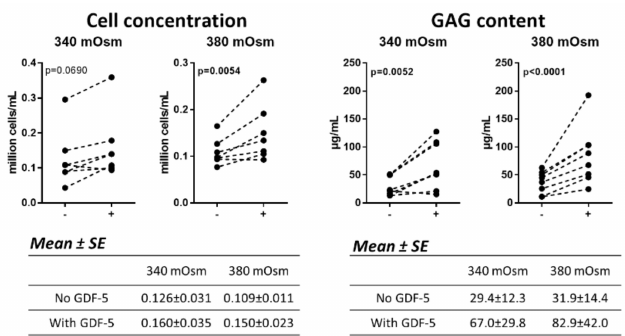
Figure 4. Human OA chondrocytes were cultured for three weeks in alginate at 340 or 380 mOsm and were left untreated (-) or were treated for two weeks with GDF-5 at 300 ng / mL ( + ). The alginate beads were then dissolved, and the cell and GAG content measured in the alginate. Data on the graphs represent the mean of technical replicates ( n = 3–6). Statistical analysis was performed on all donors together ( n = 7–8 donors). p values are shown on the graphs and are bold when p ≤ 0.05. The means and standard errors of the mean (SE) for all donors together are tabulated below the